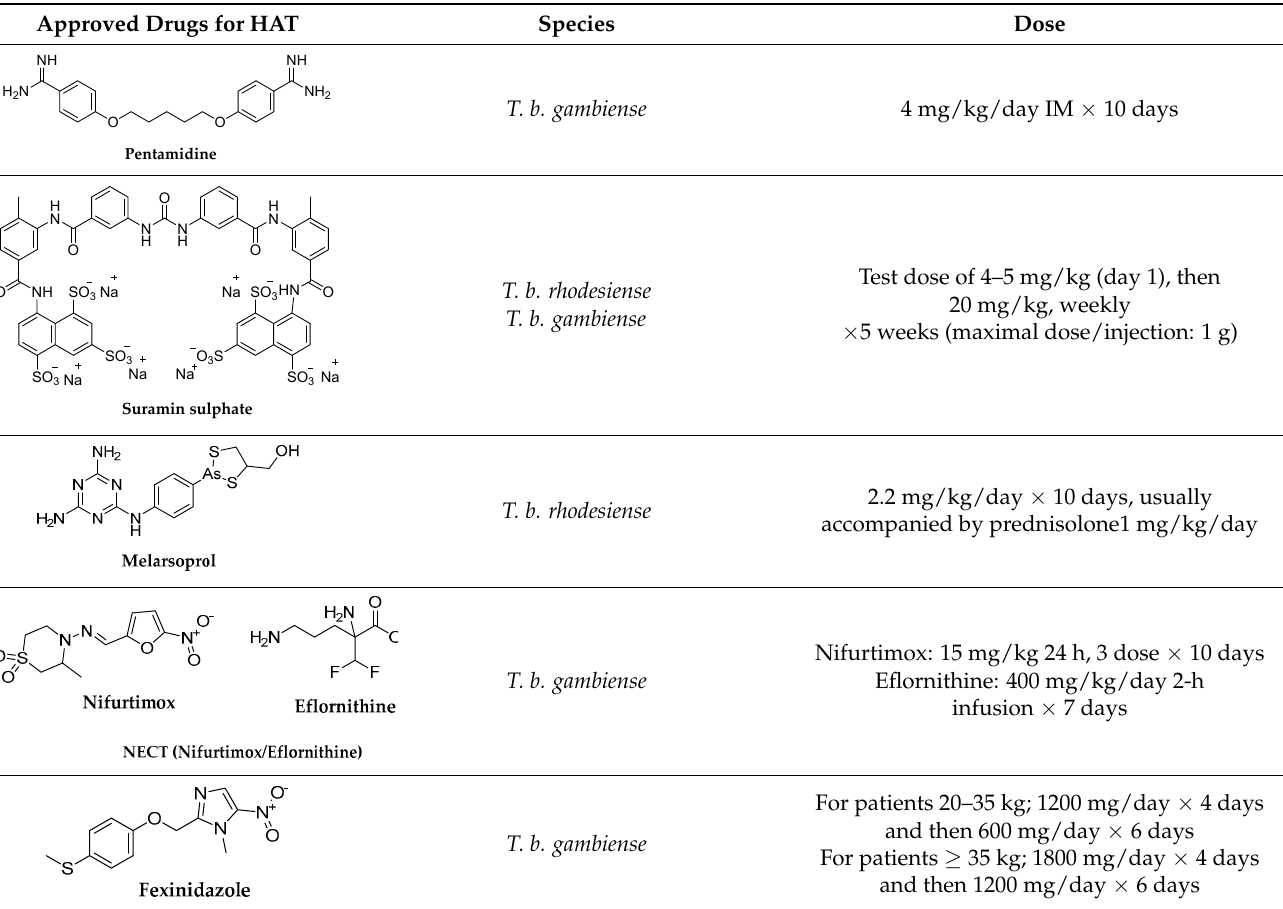
Table 1. Drugs in current treatment for Human African Trypanosomiasis (HAT).